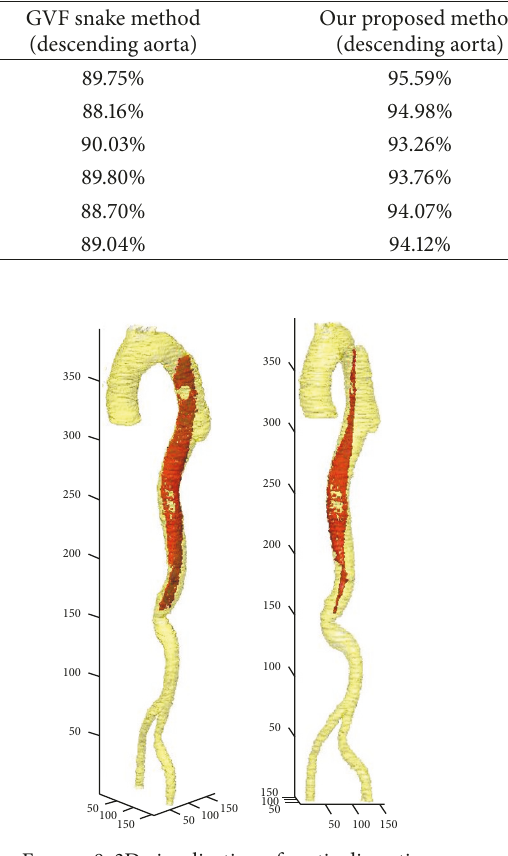
Figure 7: 3D visualization of the aorta region. Figure 8: 3D visualization of aortic